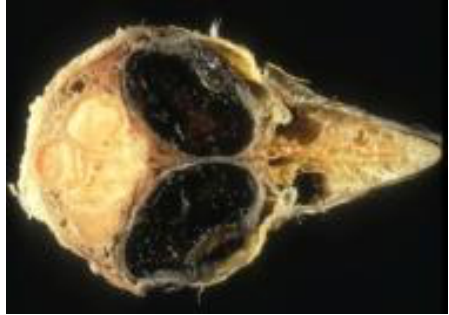
Figure 5. Sectional view of woodpeckers’ head [48].